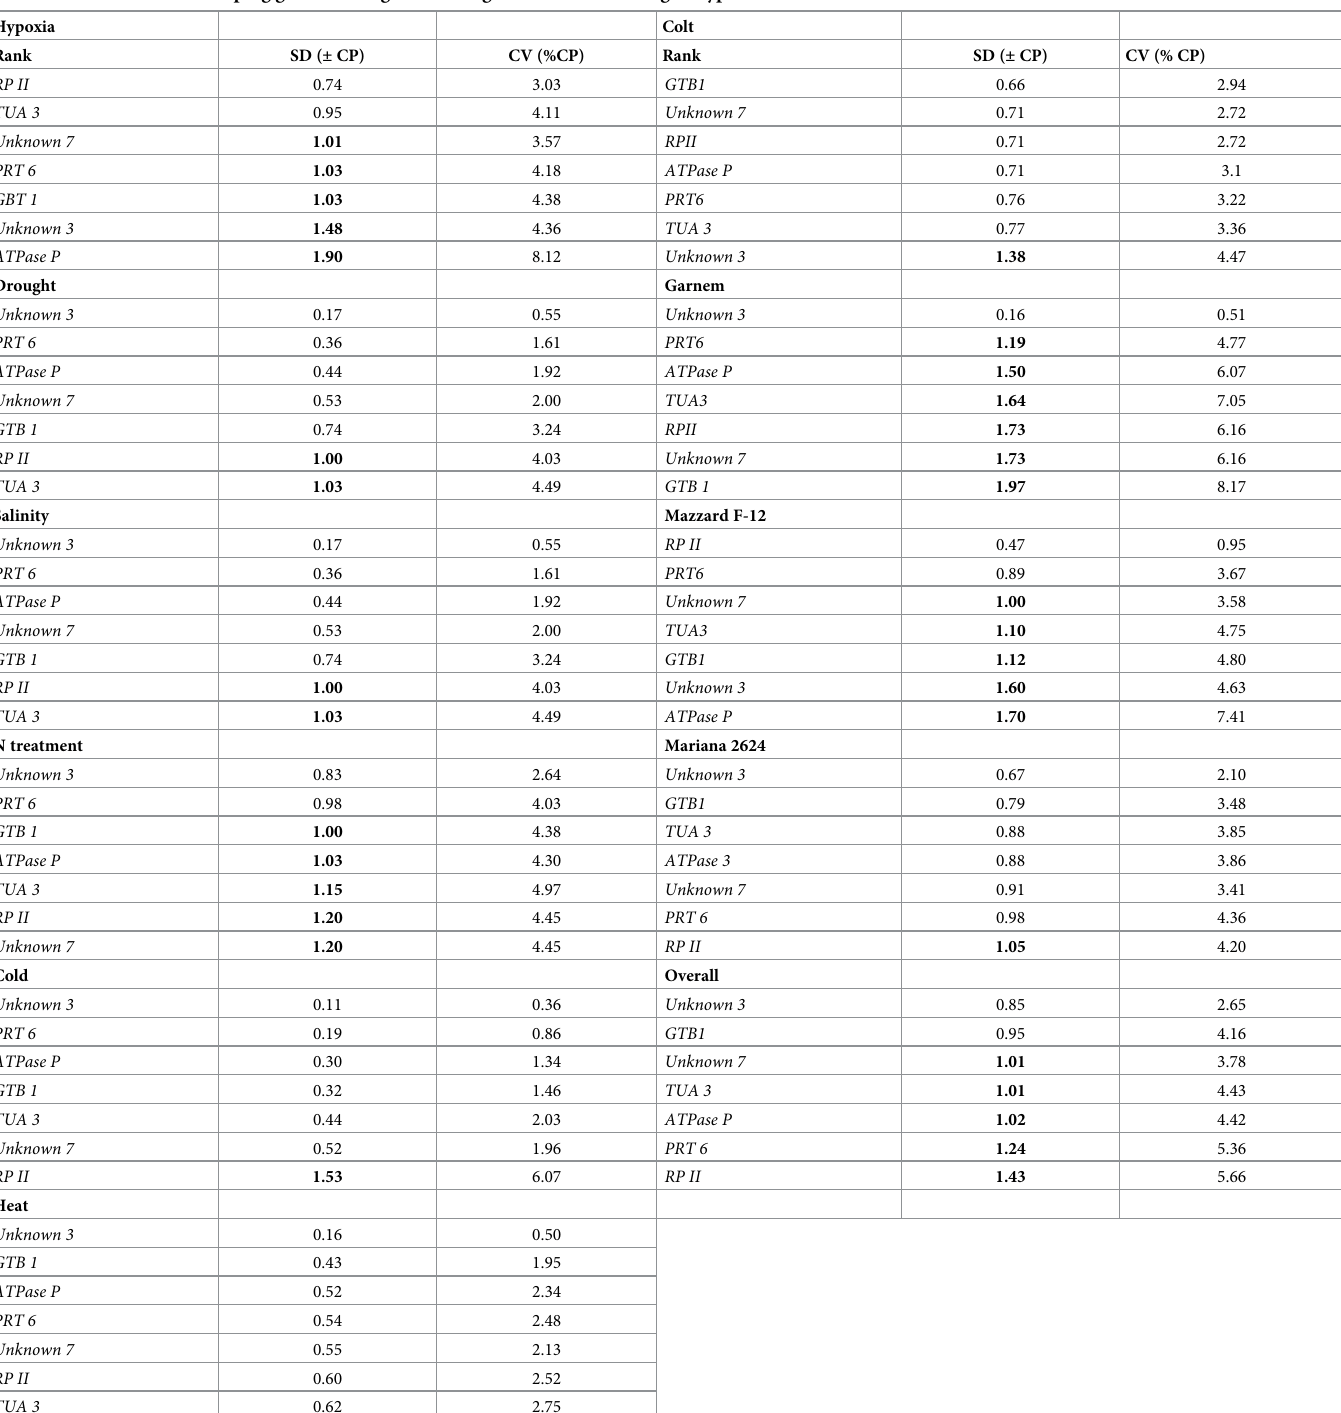
Table 5. Candidate housekeeping genes ranking considering each treatment and genotype. Hypoxia